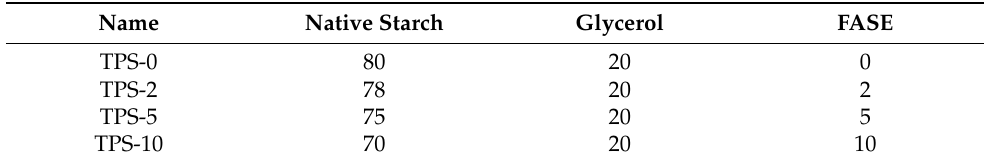
Table 2. Initial composition (% w / w ) of the